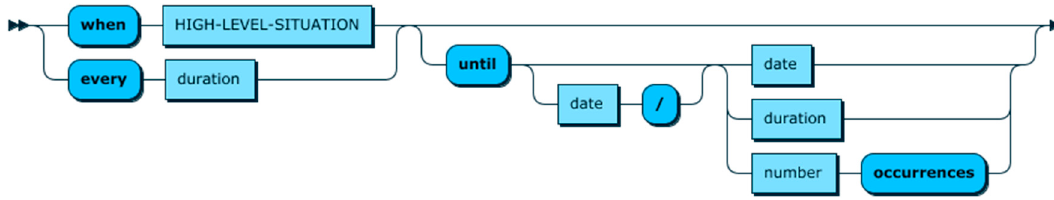
Figure 13. SUBSCRIPTION clause production rule.